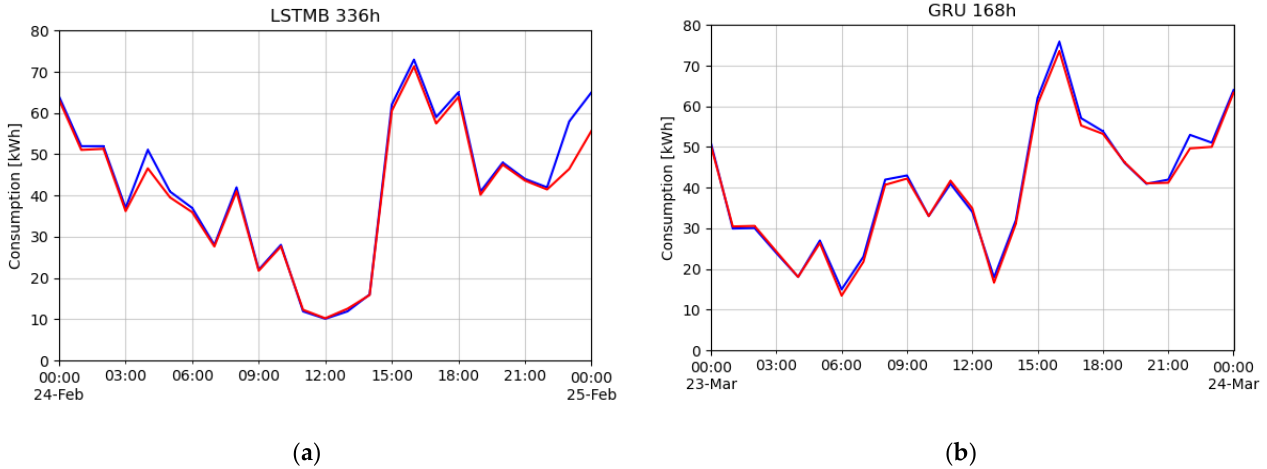
Figure 9. Predictions for one day in: ( a ) winter by LSTMB-336 h; ( b ) spring by GRU-168 h (red line is for predicted values, blue line is for measured values).